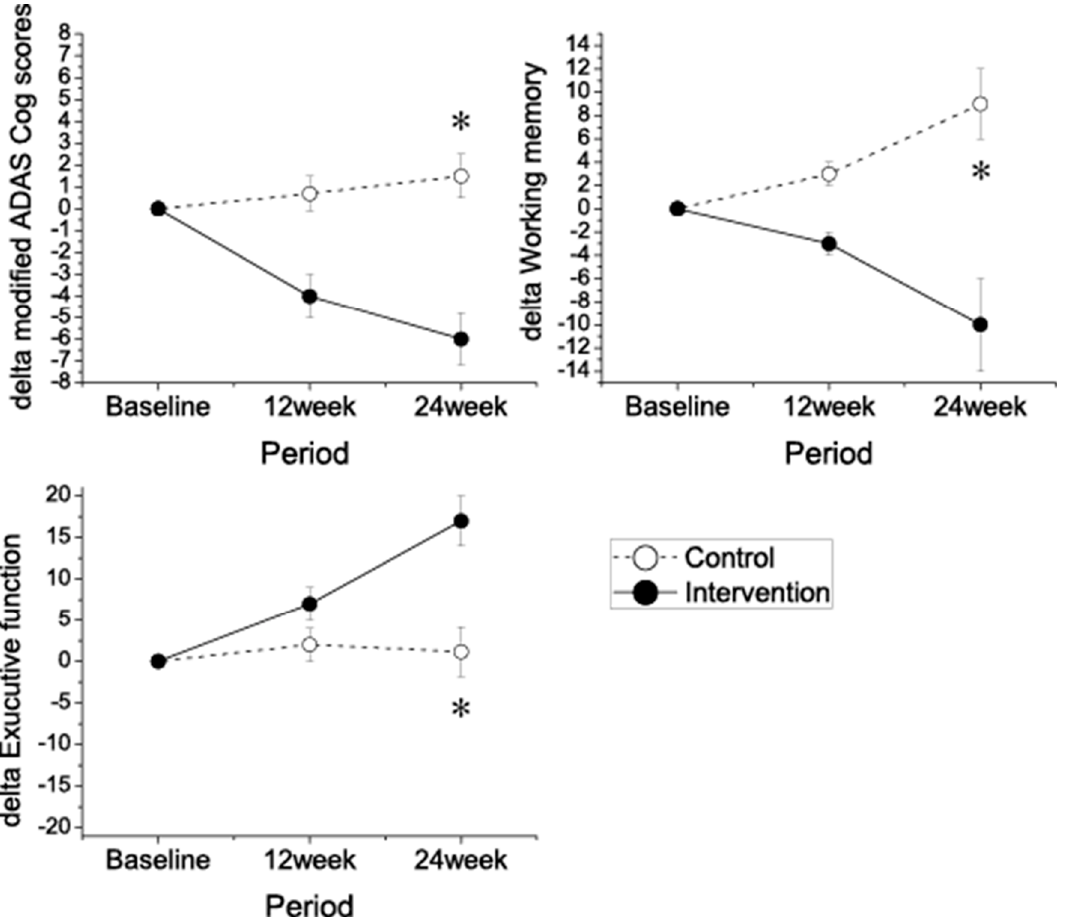
Figure 2. Change in cognitive performance during the 24 week intervention. Mean change in modified the Alzheimer’s Disease Assessment Scale-Cognitive Subscale ADAS-Cog score from baseline (negative differences correspond to lower scores, indicating performance improvement). Error bars are SEM; p - value ( p < 0.05) from mixed-model repeated measure analysis, group × time interaction. * p < 0.05.